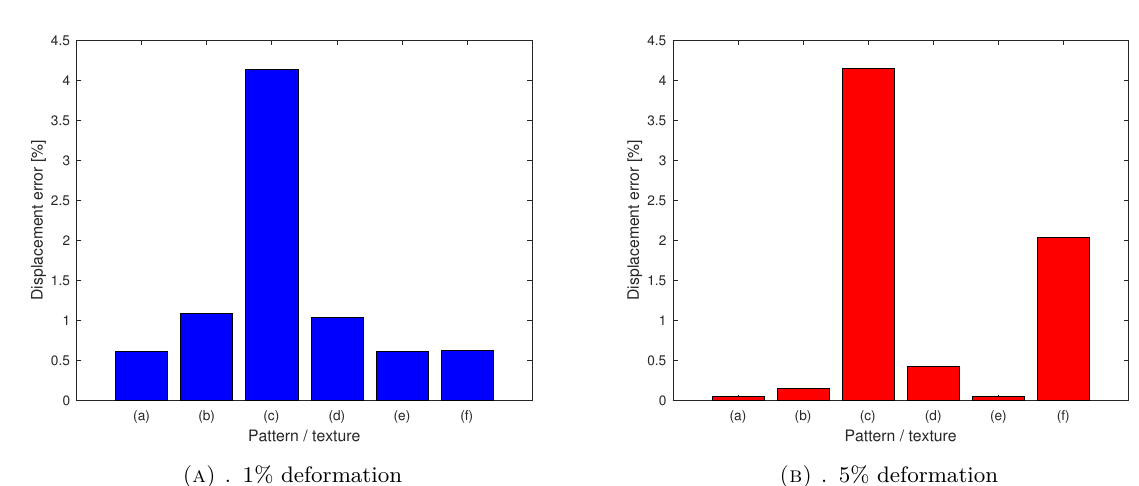
Figure 8. Displacement error for 30 × 30 px subset